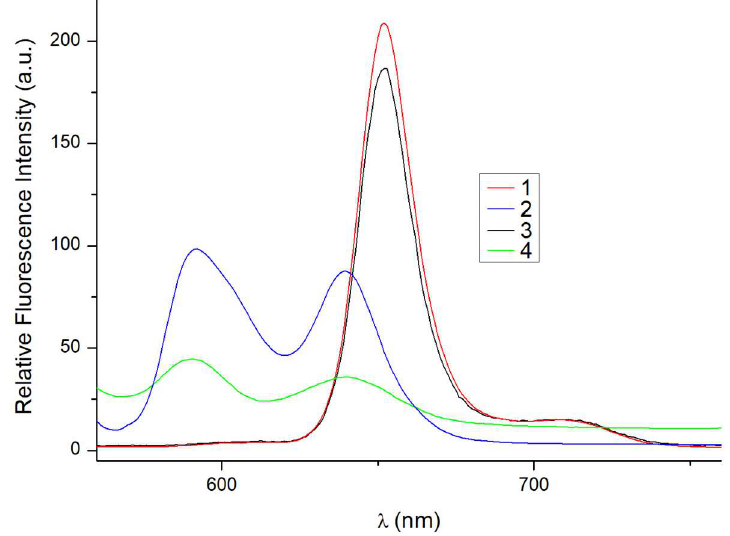
Figure 2. Fluorescence spectra of triads 1 – 4 in CHCl 3 . Optical density (OD) of the sample solution was fixed at 0.15.